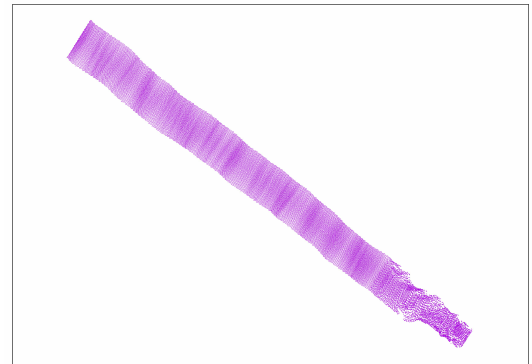
Figure 14. D-P thinning method of 11% thinning rate